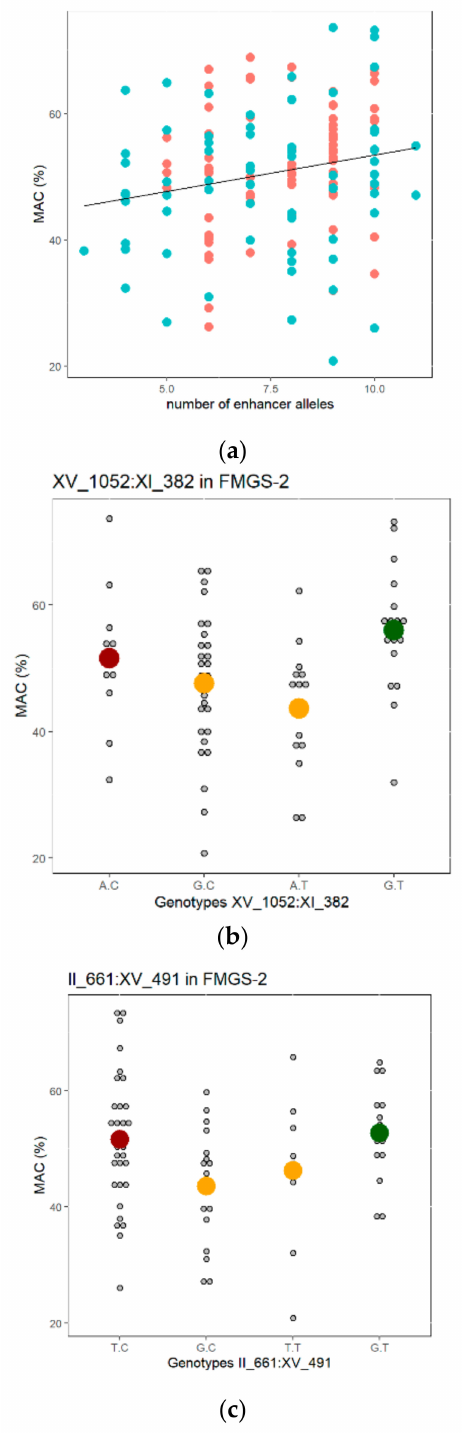
Figure 5. Overall QTL effect and pair wise interactions. ( a ) Linear relationship between the number of enhancer alleles and the MAC value in the 154 FMGS’ progenies tested; the red and blue dots represent the FMGS-1 and FMGS-2 progenies, respectively. ( b , c ) Genetic interactions between QTLs observed in the FMGS-2 population (72 individuals). The red, orange, and green dots are the average values observed for the bad, intermediate, and good combinations